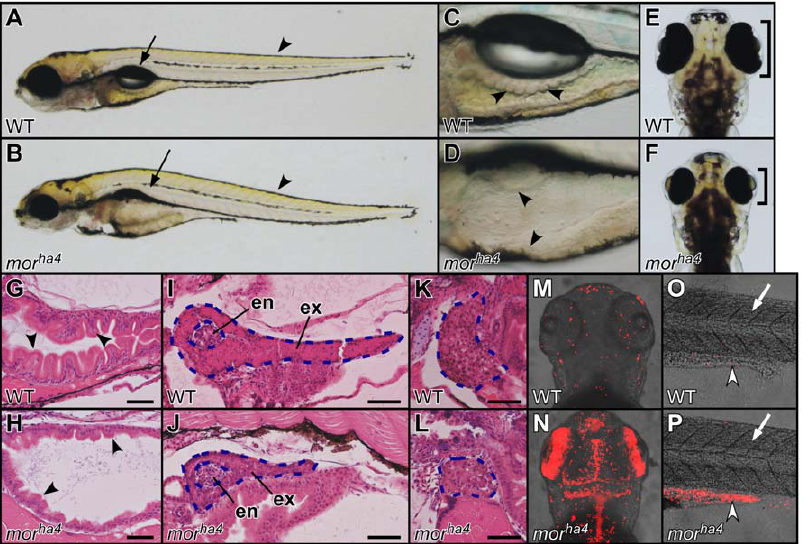
Figure 1. Phenotype of the mor ha4 mutant. (A–F) Lateral (A–D) and dorsal (E, F) views of live WT and mor ha4 larvae at 5.5 dpf. The swim bladder failed to inflate (arrows in A, B), the intestine lacked folds (arrowheads in C, D), and the retinae were reduced in size (brackets in E, F) in the mor ha4 mutant. Conversely, somite formation in the mor ha4 mutant appeared normal (arrowheads in A, B). (G–L) Sagittal sections of 5.5-dpf larvae stained with hematoxylin and eosin. The intestine lacked folds and was thin walled (arrowheads in G, H), and the exocrine pancreas (blue dotted lines in I, J) and liver (blue dotted lines in K, L) were small in the mor ha4 mutant. In contrast, the endocrine pancreas (blue dotted lines in I, J) in WT larvae was indistinguishable from that in mor ha4 larvae. Scale bars, 50 m m. (M–P) Dorsal views, anterior to the top (M, N). Lateral views, anterior to the left (O, P). Apoptotic cells were detected using the TUNEL method. An increase in apoptotic cells was evident in the brain, retinae, and posterior intestine of the mor ha4 larvae (white arrowheads in O, P) compared to WT larvae, but not in the mor ha4 somite (white arrows in O, P). en, endocrine pancreas; ex, exocrine pancreas.